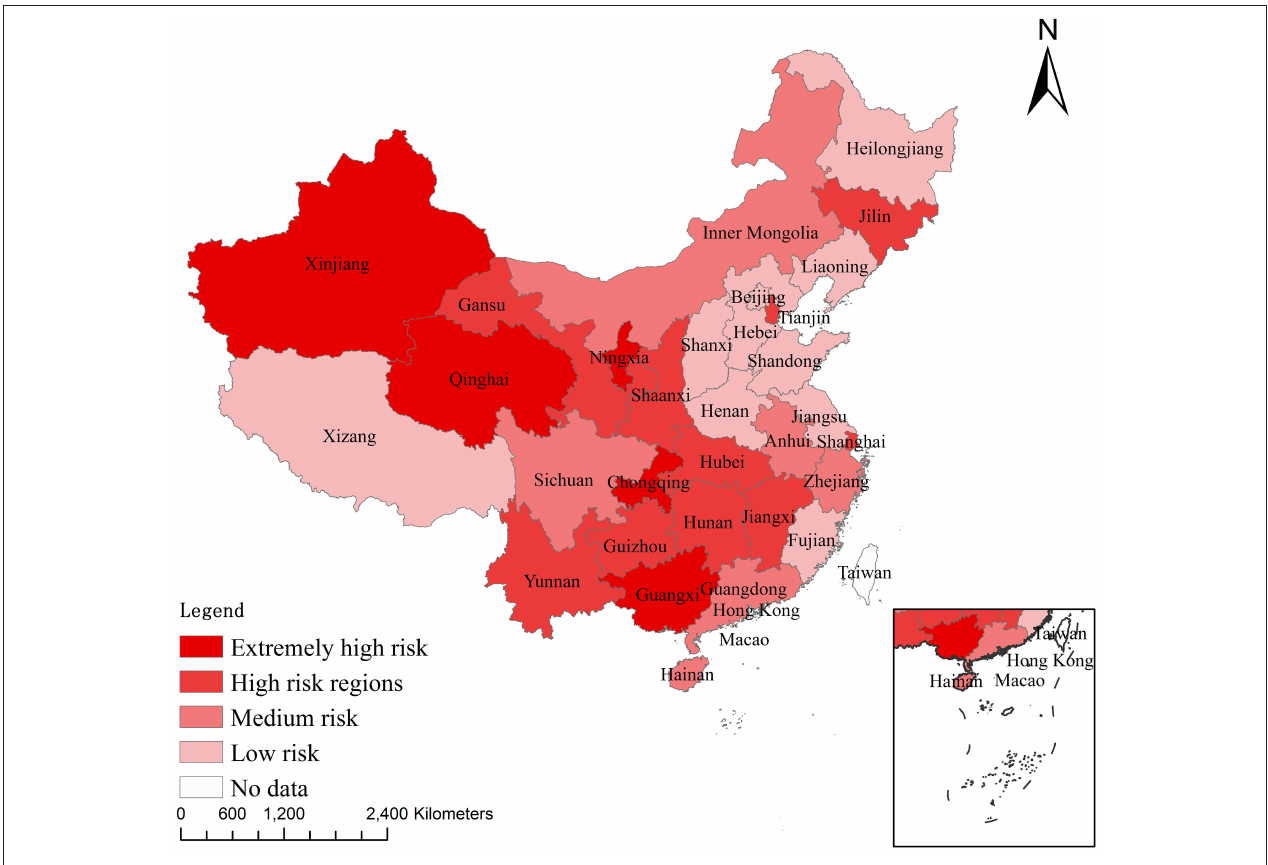
FIGURE 1 | Animal epidemic risk ranking.